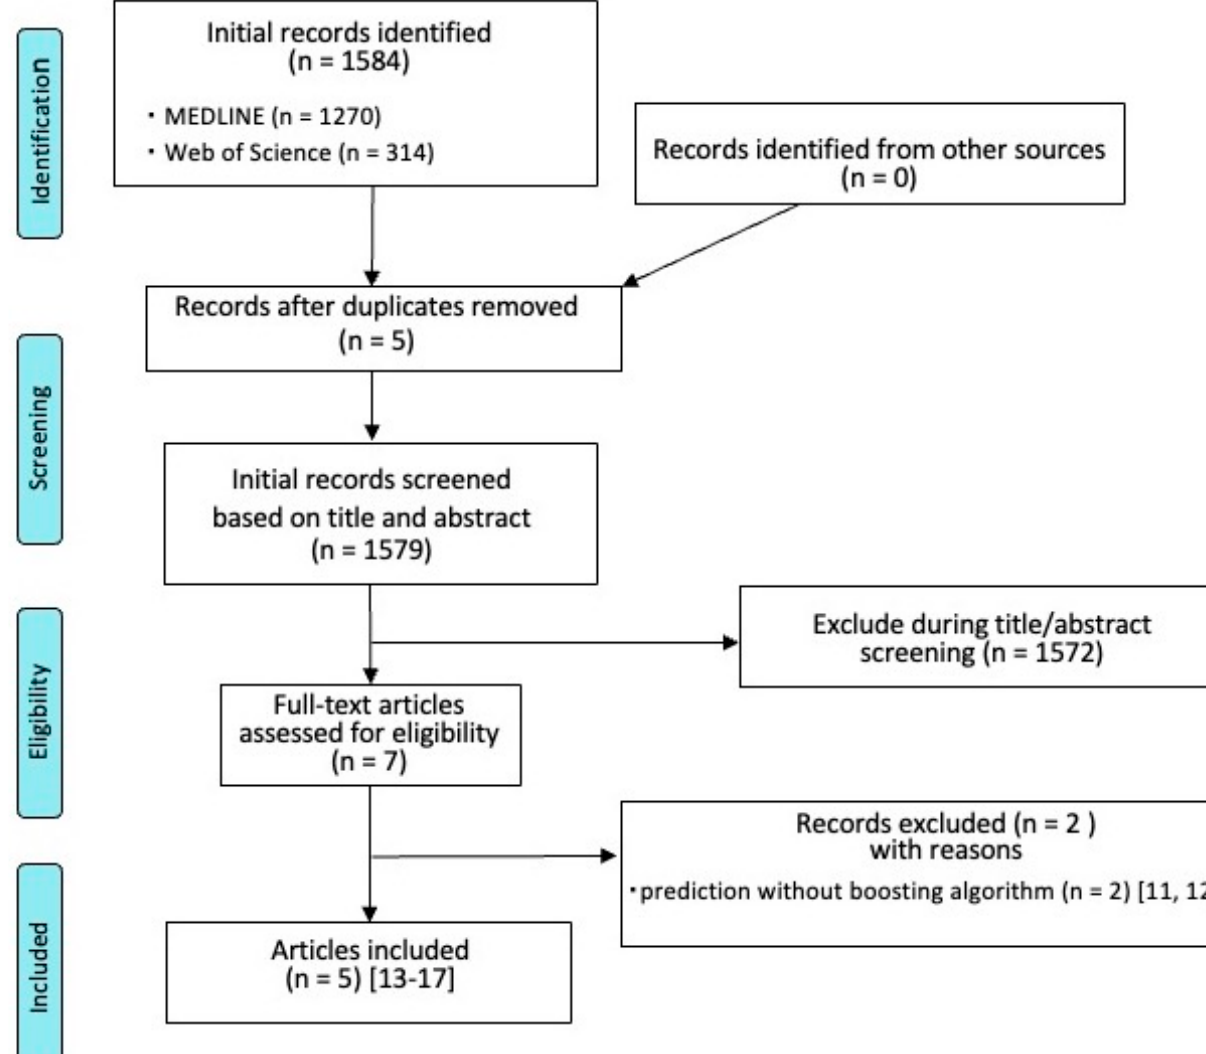
Figure 1. Flow diagram for the selection of studies.